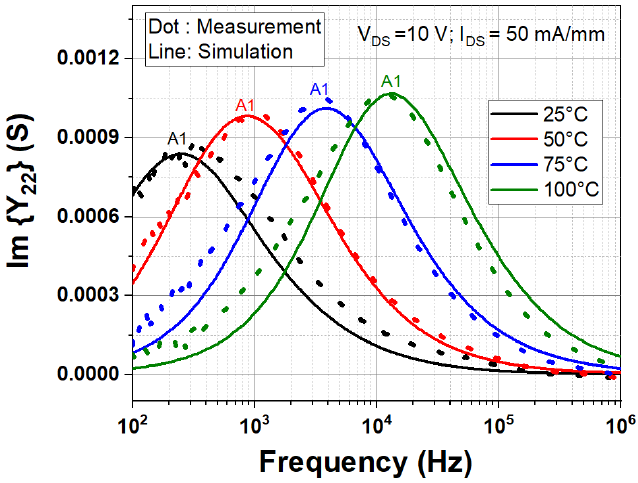
Figure 14. The simulated LF Y 22 characteristics at V DS = 10 V are validated with the measured spectra ◦ for different temperatures of 25 to 100 °C. for different temperatures of 25 to 100